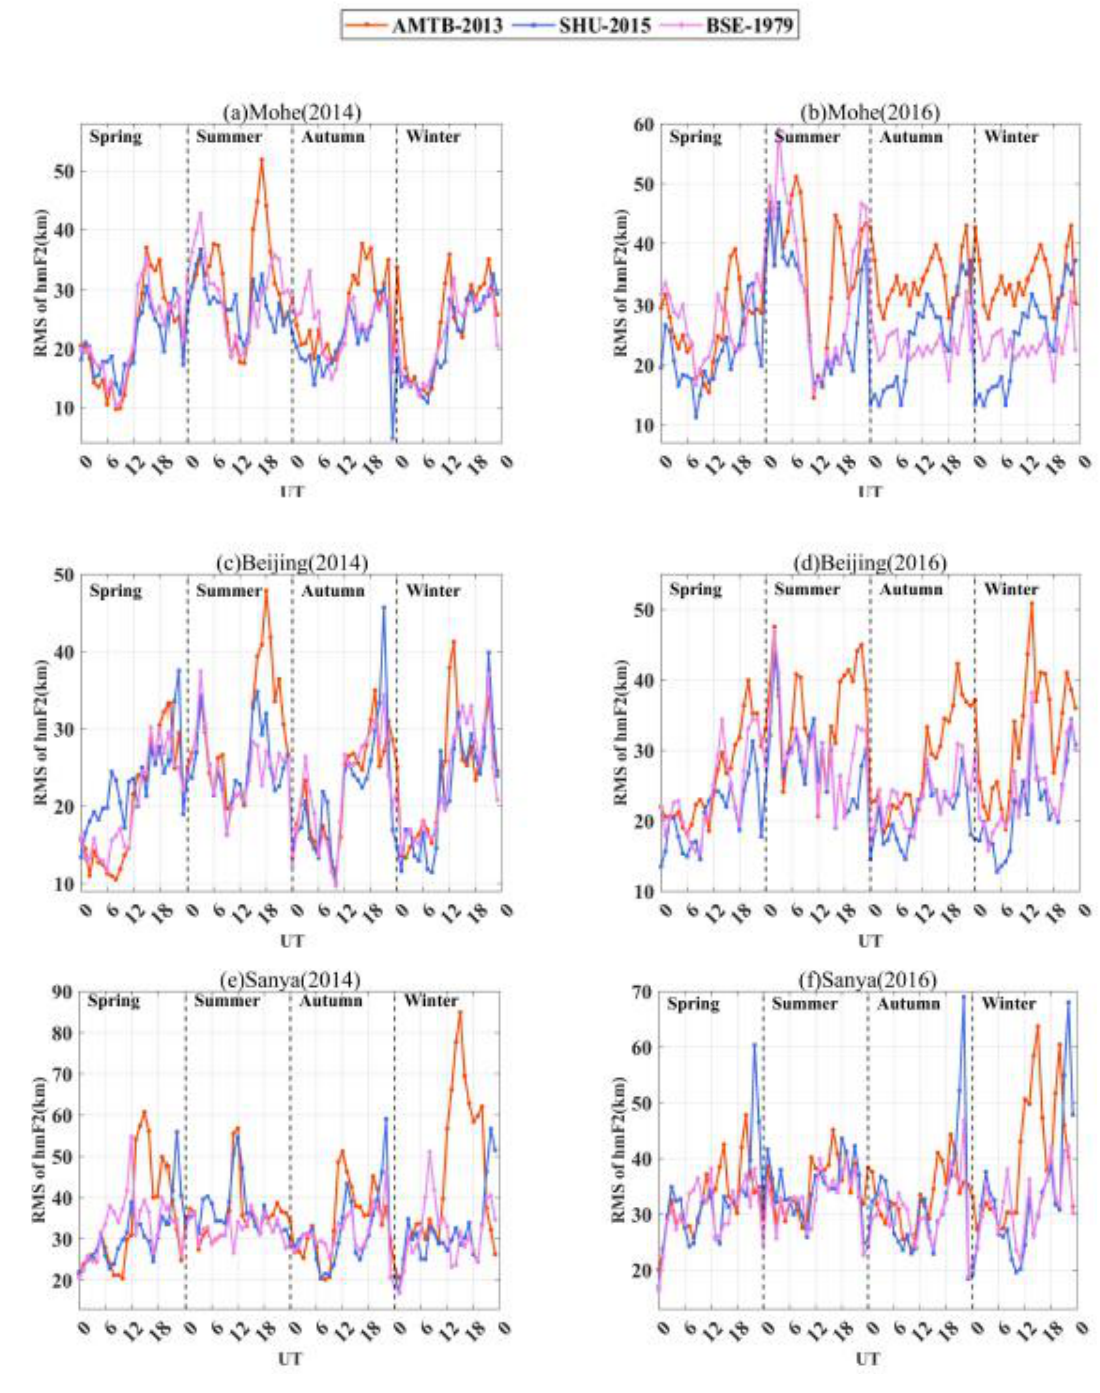
Figure 8. Diurnal RMS variation for three IRI-2016 predicted hmF2 from the ionosonde hmF2 in the four different seasons of the years 2014 and 2016 at Mohe, Beijing and Sanya over China. ( a ) Mohe(2014), ( b ) Mohe(2016), ( c ) Beijing(2014), ( d ) Beijing(2016), ( e ) Sanya(2014), ( f ) Sanya(2016). Table 5. Daily average RMS values of IRI-2016 AMTB-2013, SHU-2015 and BSE-1979 predicted hmF2 from the ionosonde hmF2 in the four different seasons for the years 2014 and 2016 at Mohe, Beijing and Sanya over China (unit: km) .